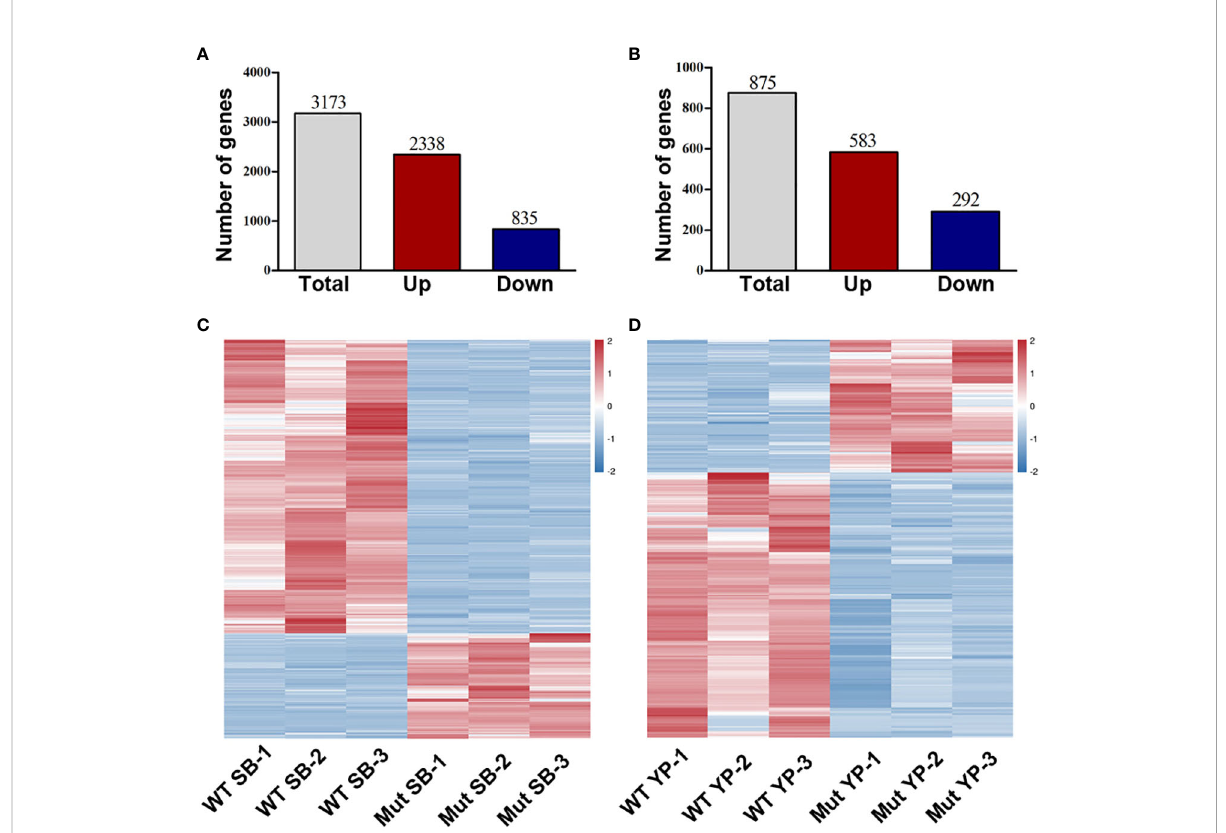
FIGURE 7 RNA-seq analysis of DEGs between WT and mib1 mutants. (A) Number of DEGs of the shoot buds between WT and mib1 mutants. (B) Number of DEGs of the young pods between WT and mib1 mutants. (C) Heat map of the DEGs of the shoot buds between WT and mib1 mutants. (D) Heat map of the DEGs of the young pods between WT and mib1